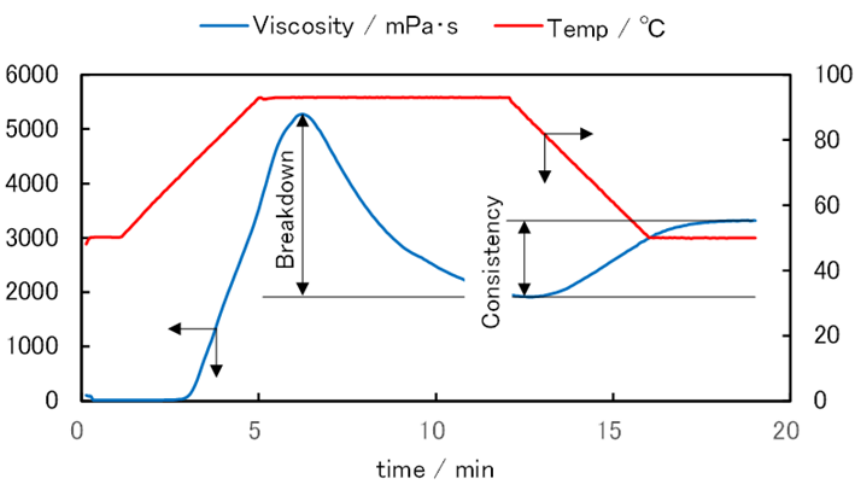
Figure 3. A representative measurement result (Koshihikari) and a definition of breakdown and consistency.